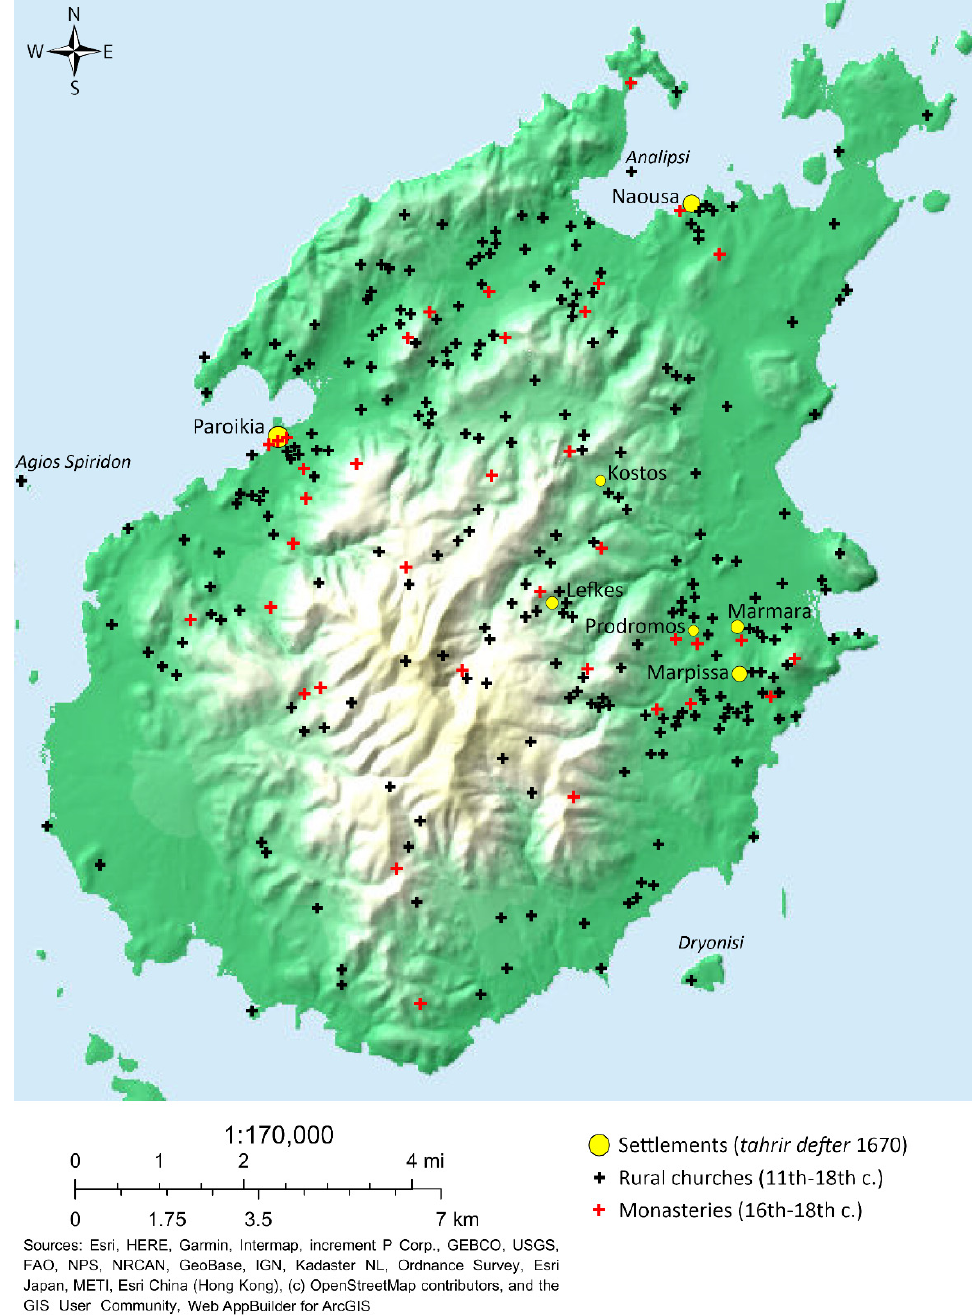
Figure 7. Monasteries (red crosses) and churches (black crosses) in the countryside of the island of Paros and its offshore islets (map by the author).